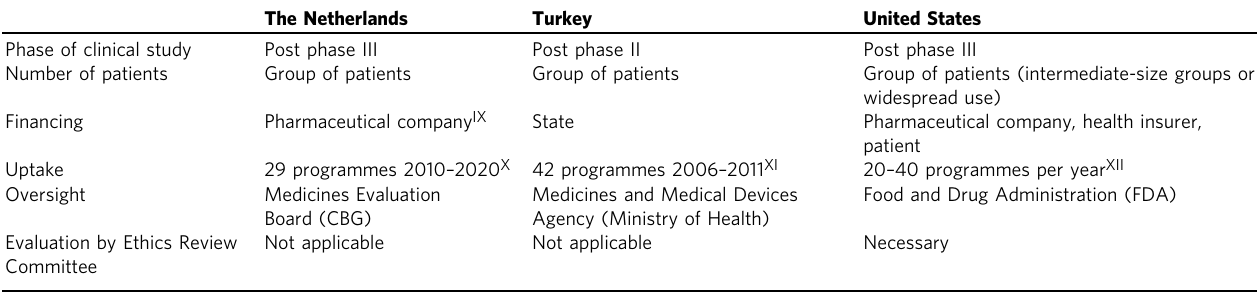
Table 3 Compassionate use programmes in the Netherlands, Turkey and the United States.